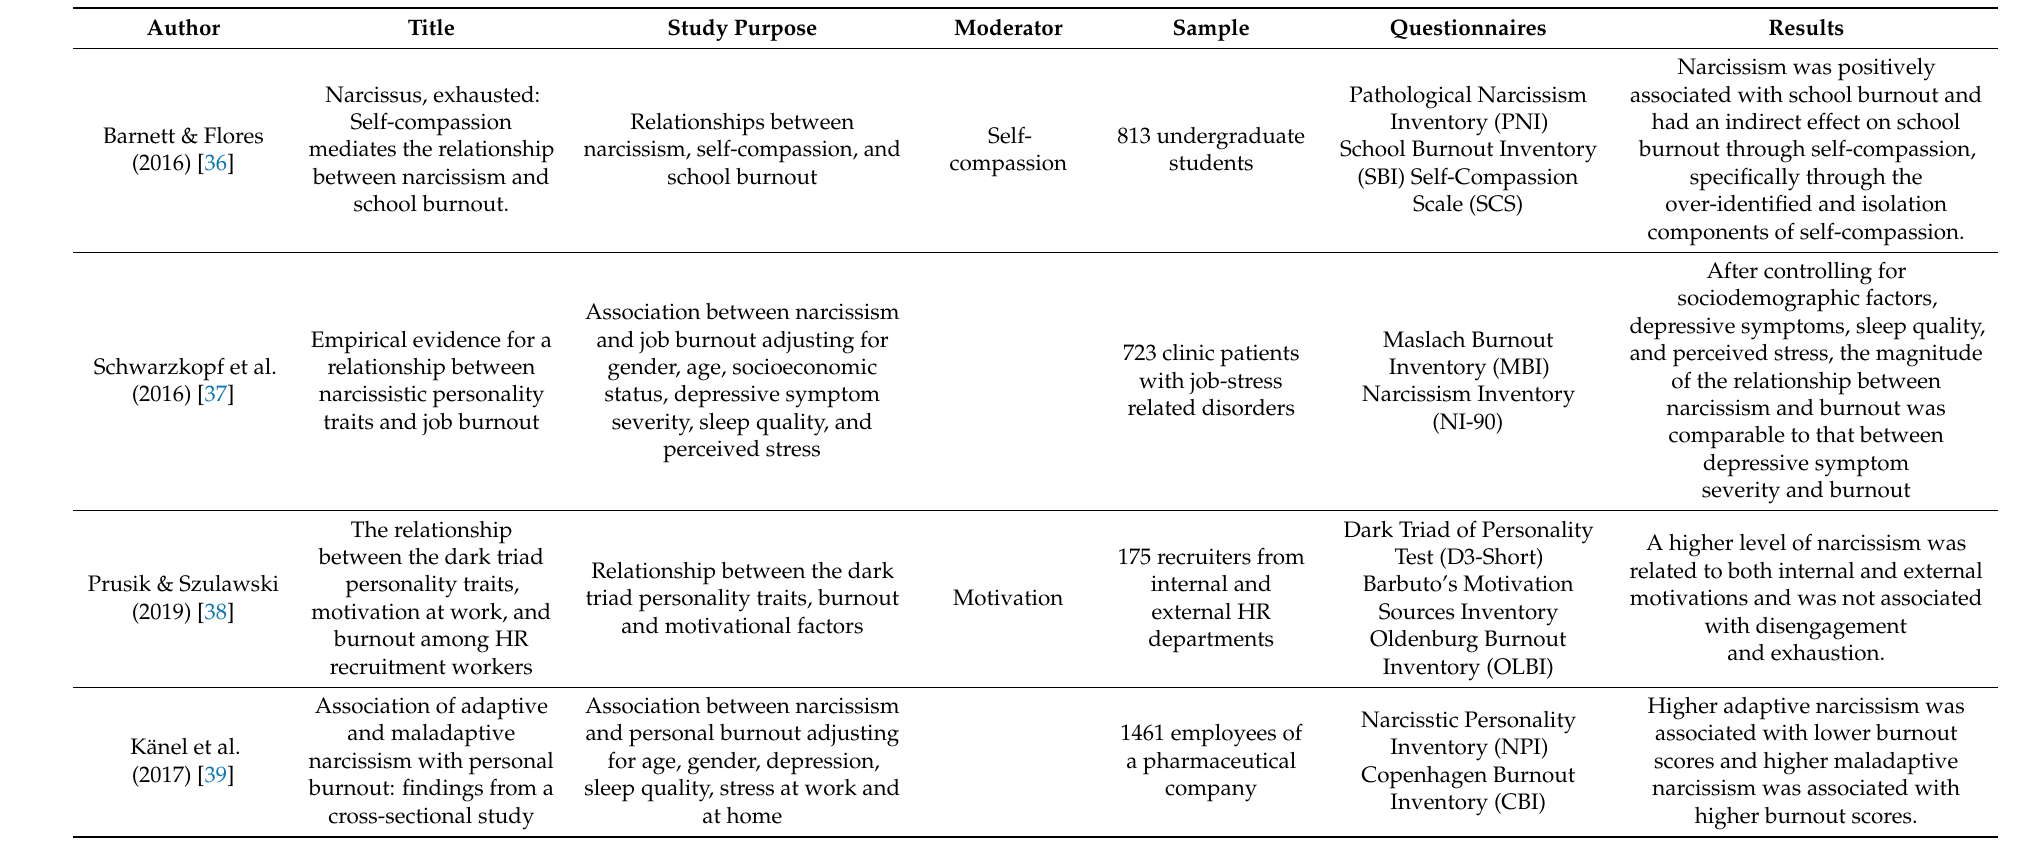
Table 1. Overview of studies on the relationship between narcissism and